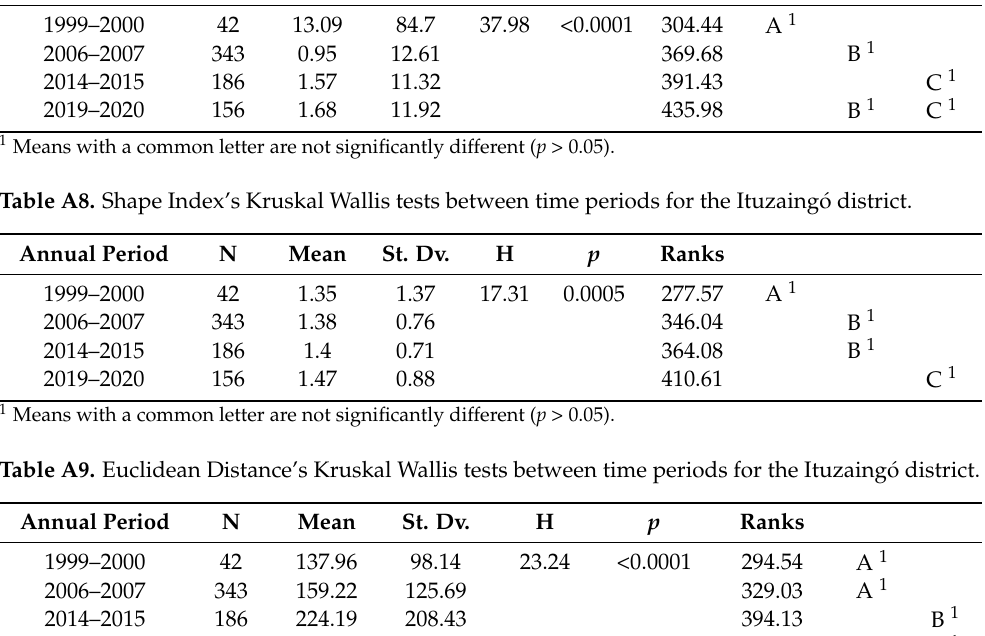
Table A7. Area’s Kruskal Wallis tests between time periods for the Ituzaing ó district. Annual Period Mean St. Dv.